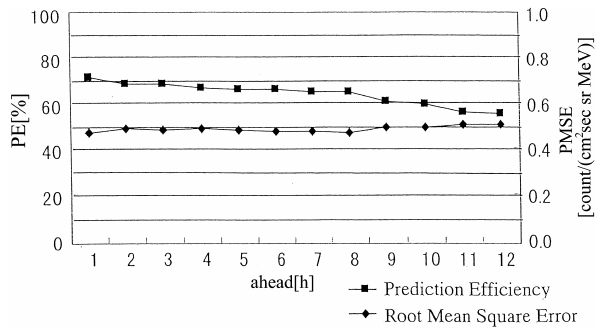
Fig. 5. Change of prediction efficiency (PE) and root-mean-square error (RMSE) for the period 1 to 12h